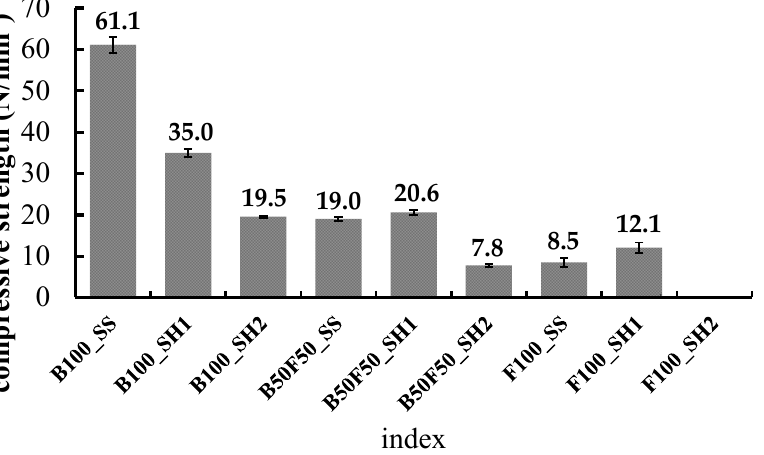
Figure 2. Compressive strength of each specimen at 8 weeks.